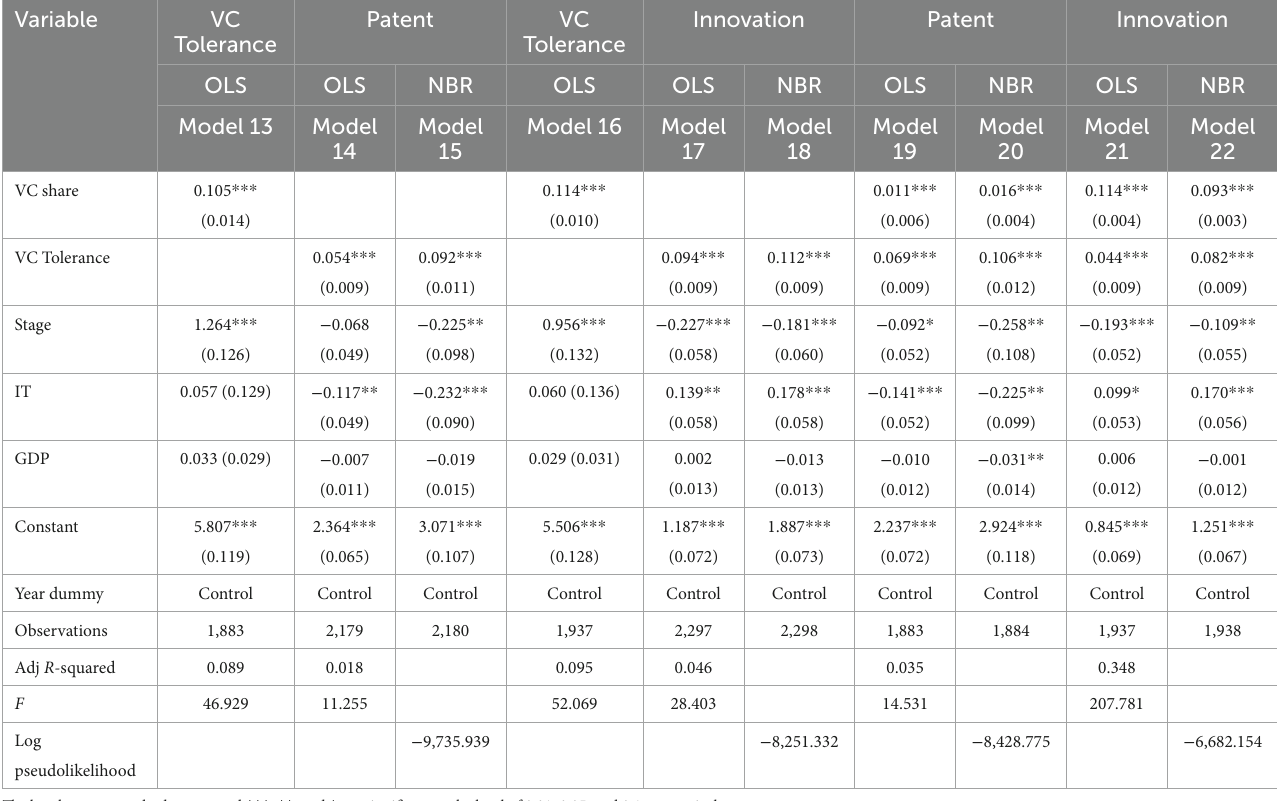
TABLE 5 Impact of venture capital shareholding and failure tolerance on enterprise innovation performance.